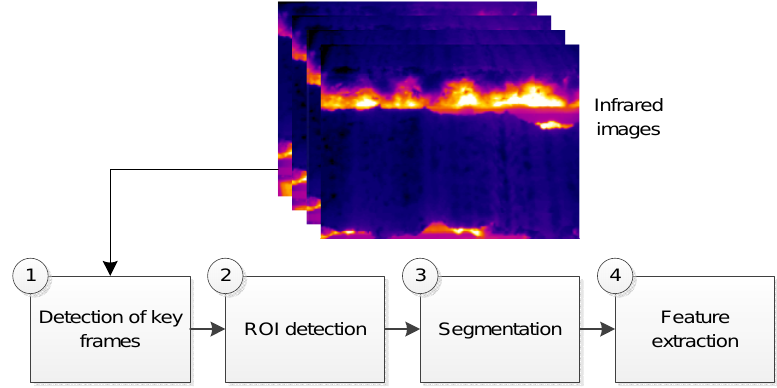
Figure 4. Summary of the proposed approach for sintering burn-through point (BTP) monitoring.